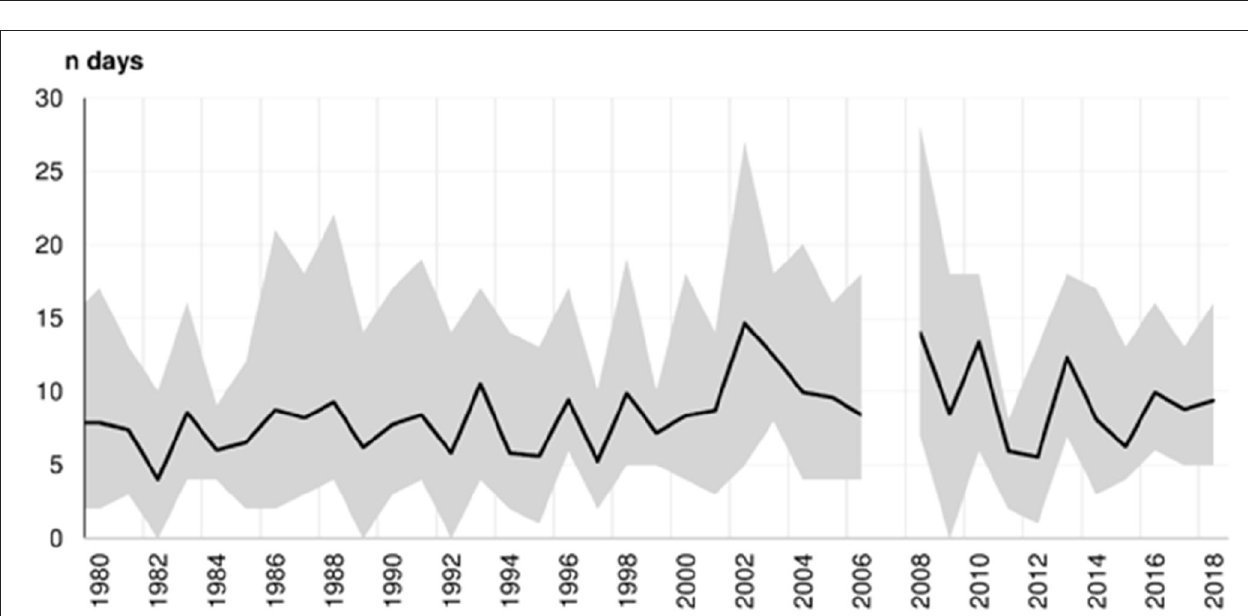
FIGURE 10 | Average number of days per year with precipitation above 15 mm/day in the MMA. The shading corresponds to the range in the number of days in 17 weather stations in the MMA. The gap around 2007 corresponds to missing (incomplete) daily data in most stations in the region.